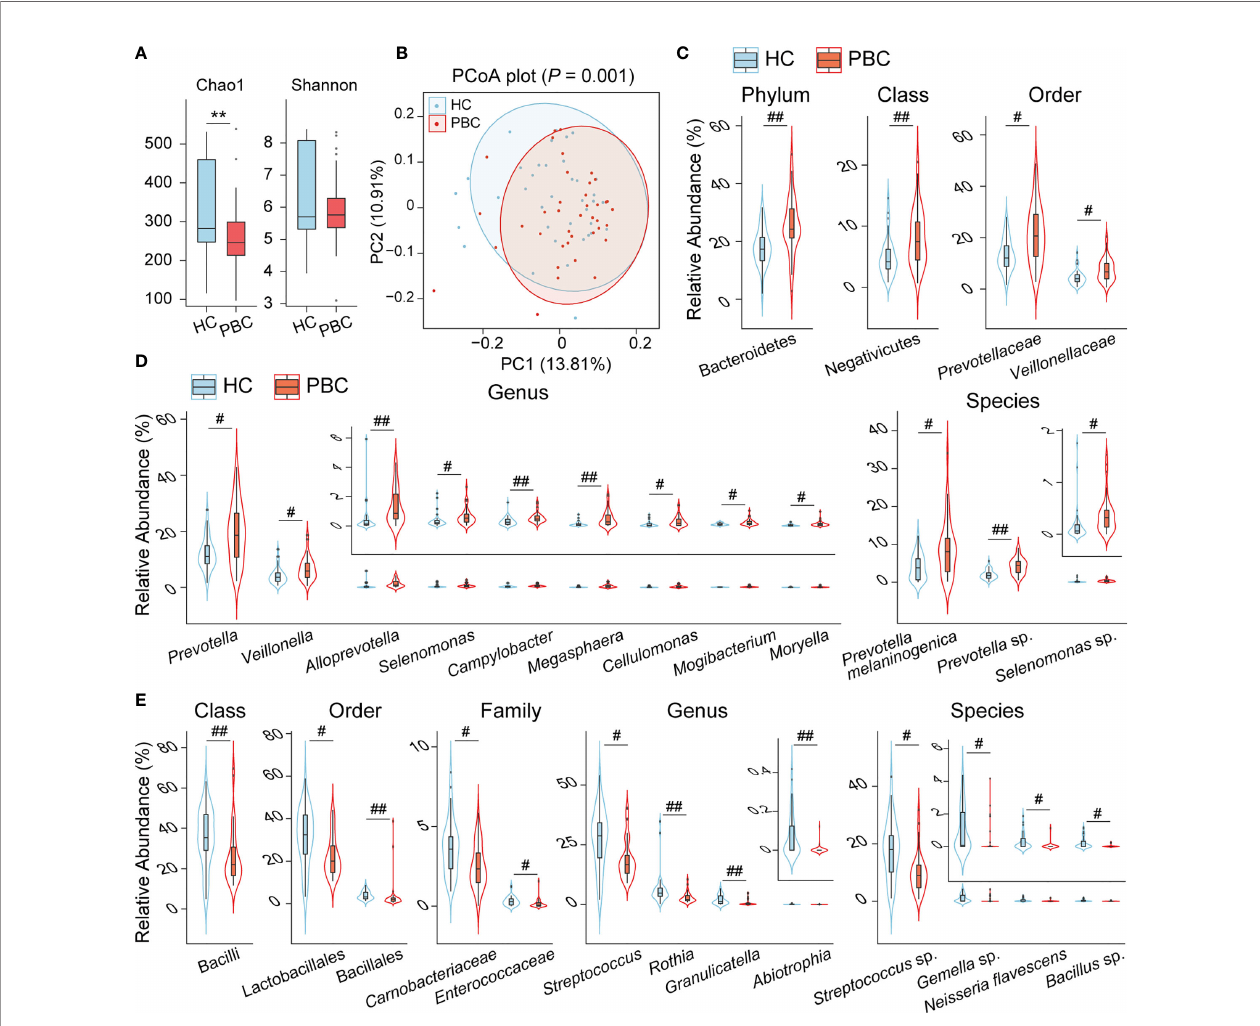
FIGURE 1 | The salivary microbiota of PBC patients is distinct from that of HC subjects. (A) Box plot and distribution of the Chao1 index and Shannon index. (B) PCoA plot based on the unweighted UniFrac distance. (C) Phyla, classes, and orders enriched in PBC saliva. (D) Genera and species enriched in PBC saliva. (E) Classes, orders, families, genera and species depleted in PBC saliva. ** P < 0.01; # P adj < 0.05; ## P adj <